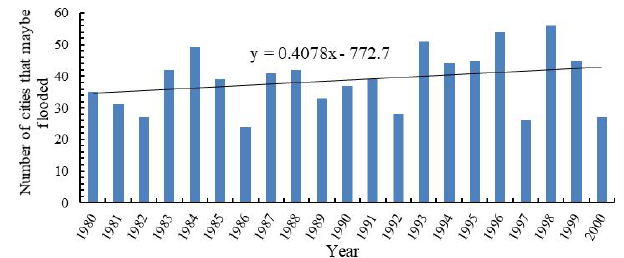
Figure 6. Number of cities that have potential to be flooded (Zhang, 2003).